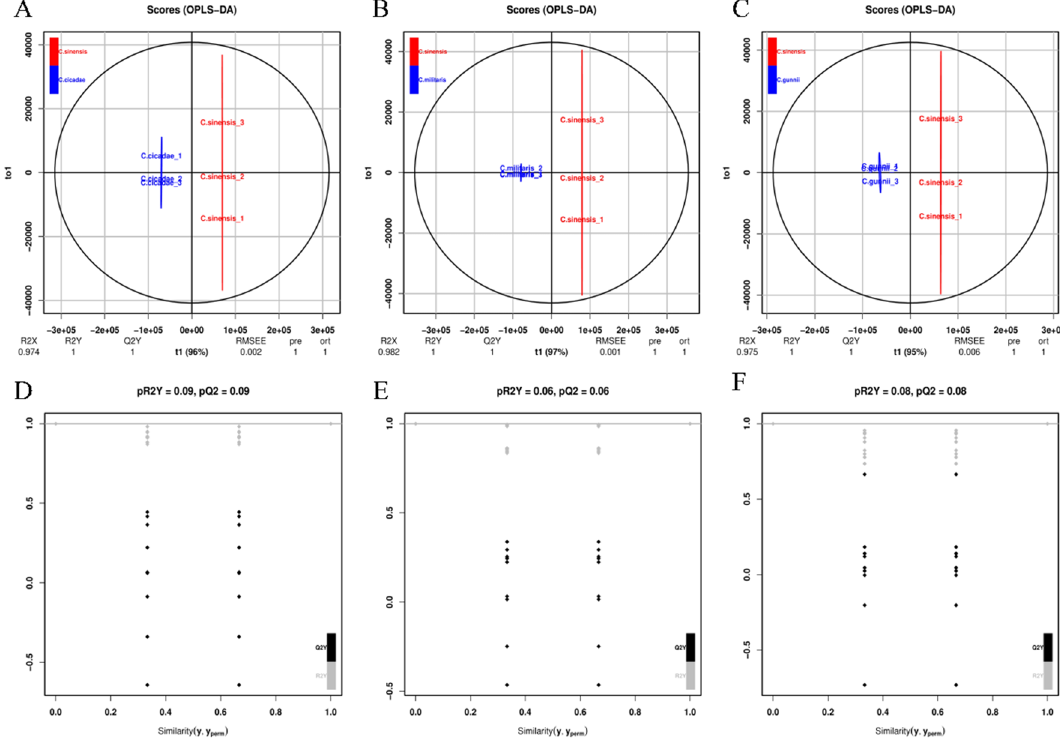
Figure 3. OPLS-DA model score diagram and model verification diagram of C. sinensis , C. cicadae , C. militaris and C. gunnii samples. ( A ) Score diagram of OPLS-DA model between C. sinensis and C. cicadae . ( B ) Score diagram of OPLS-DA model between C. sinensis and C. militaris . ( C ) Score diagram of OPLS-DA model between C. sinensis and C. gunnii . ( D ) OPLS-DA model verification diagram between C. sinensis and C. cicadae . ( E ) OPLS-DA model verification diagram between C. sinensis and C. militaris . ( F ) OPLS-DA model verification diagram between C. sinensis and C. gunnii